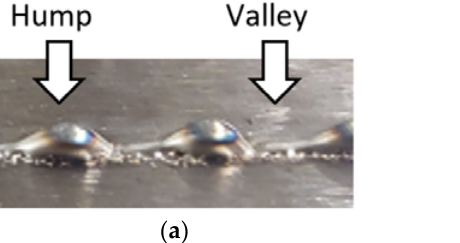
Figure 5. ( a ) Humping phenomenon (refer Nguyen et al. [49]); ( b ) normal bead; ( c ) abnormal bead. The RoI of the weld-pool/bead based on the HDR image in this study is depicted as normal and abnormal in Figure 6a,b, respectively. Compared with the metal transfer RoI, the weld-pool/bead RoI is clearly shown without the interference of arc light. The main difference between normal and abnormal cases is shown by the shape of the weld-bead; as such, additional preprocessing is not required. The defined RoI of the weld-pool/bead contains long width pixels, and the humping beads can be located at any location in